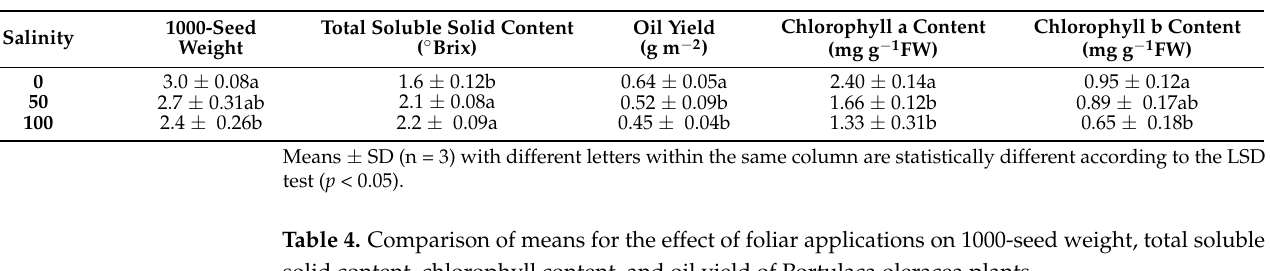
Table 3. Comparison of means for the effect of NaCl salinity on 1000-seed weight, total soluble solid content, chlorophyll content, and oil yield of Portulaca oleracea plants.